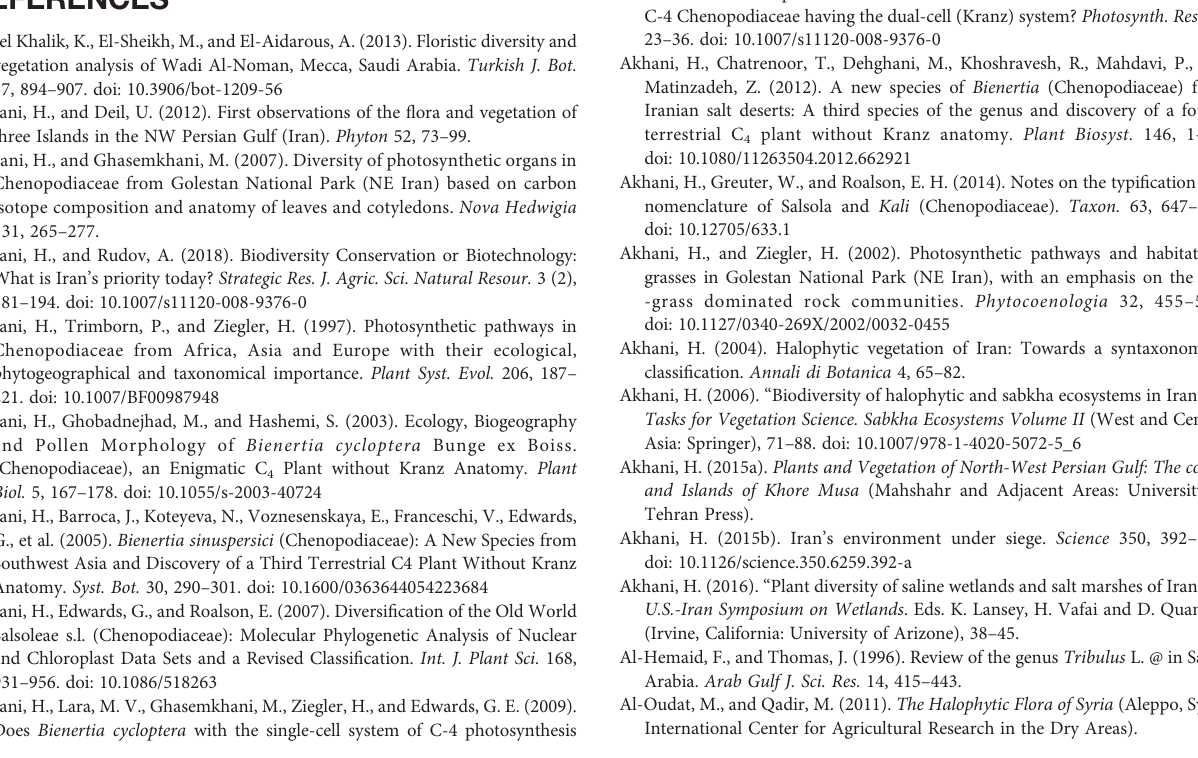
SUPPLEMENTARY FIGURE 1 | Climatic diagrams of selected 29 stations in different parts of SW Asian countries obtained from of the Iranian Meterorological Organization (IRIMO), Scholte and De Geest (2010) and Raza et al. (2015). SUPPLEMENTARY TABLE 2 | List of Polycarpaea (Caryophyllaceeae) species known from SW Asia which we could not test their photosynthetic type because of absence of material.